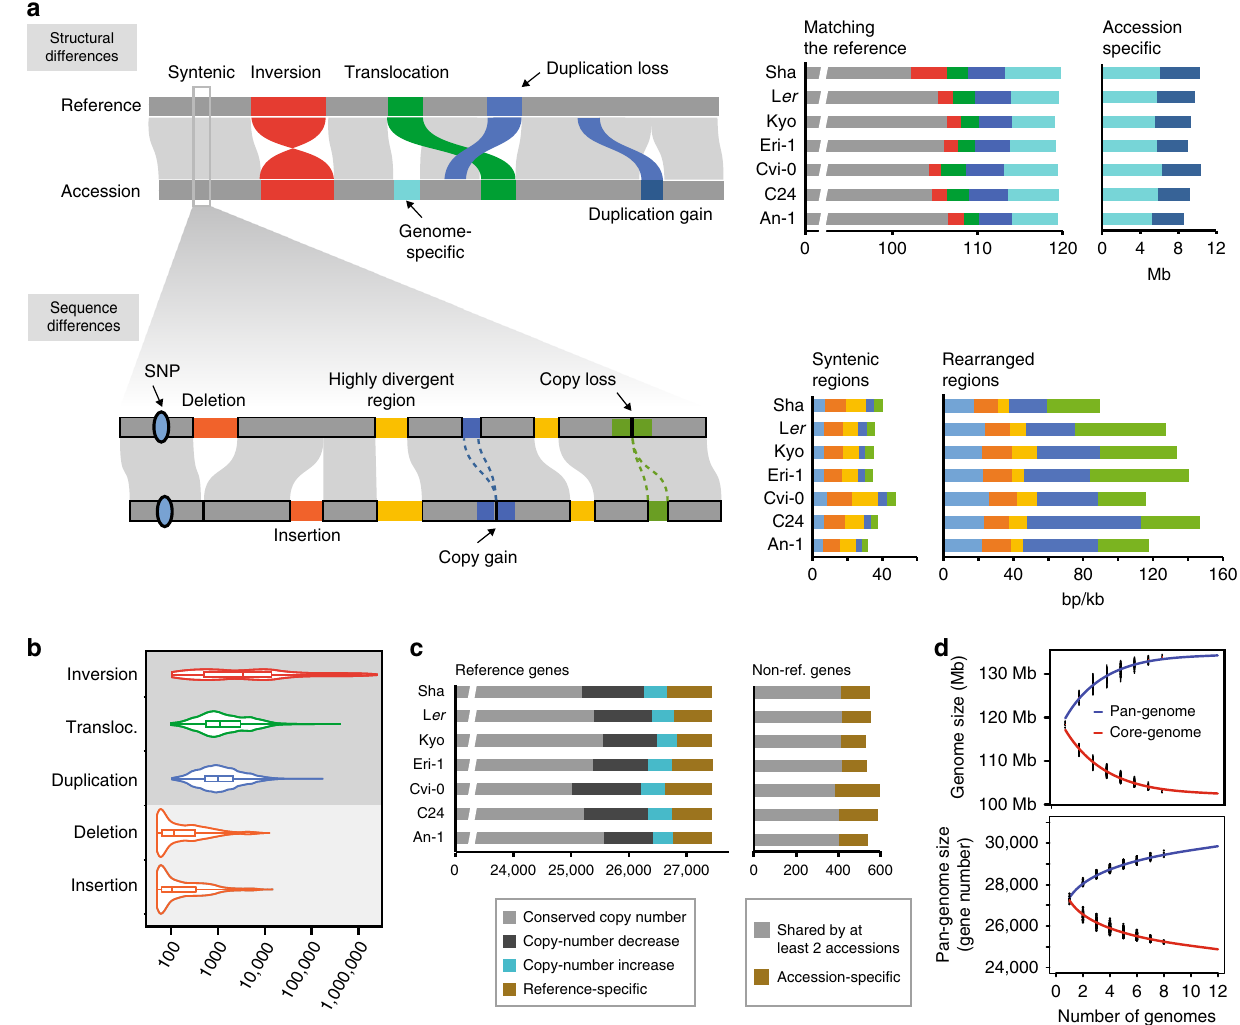
Fig. 2 Structural and sequence differences between the genomes. a Schematic of the structural differences (upper panel) and sequence variation (lower panel) that can be identi fi ed between chromosome-level assemblies. Note, local sequence variation can reside in syntenic as well as in rearranged regions. The barplots on the right upper side show the total span of syntenic and rearranged regions between the reference and each of other accessions (colors match the schematic on the left): The left barplots shows the sequence span in respect to the reference sequence, while the right plot shows the sequence space, which is speci fi c to each of the accessions. The barplots on the right lower side show local sequence variation (per kb) in syntenic (left) and rearranged (right) regions between the reference and each of other accessions (again colors match the schematic on the left). b Size distributions of different types of structural and sequence variation. c Gene copy-number variations between the reference and each of the accessions. The left barplots shows the fraction of reference genes which are in gene families with conserved or variable copy numbers. The right barplots shows the number of non- reference genes found in at least two accessions, or found to be speci fi c to an accession genome. d Pan-genome and core-genome estimations for sequence (upper plot) and gene space (lower plot) were based on all pairwise whole-genome and gene set comparisons across all eight accessions. Each black point corresponds to a pan- or core-genome size estimated with a particular combination of genomes. Pan-genome (blue) and core-genome (red) estimations were fi tted using an exponential model. Source Data are provided as a Source Data fi